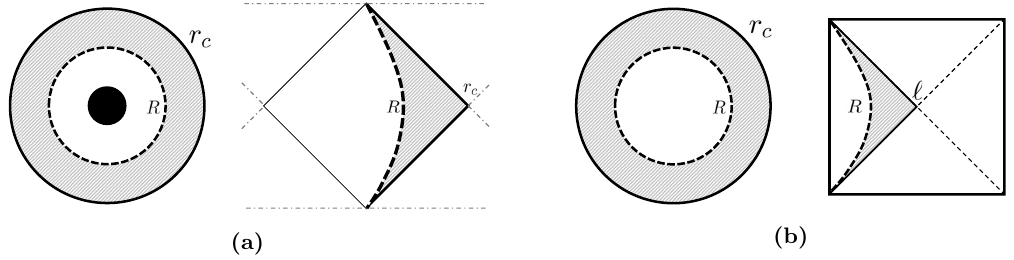
Figure 4. The black hole configuration. The system is the shaded region that extends from the black hole horizon r b to the system boundary R ( 6 = ‘/ diagram for the corresponding Lorentzian solution (right). The cosmological horizon lies outside the system.